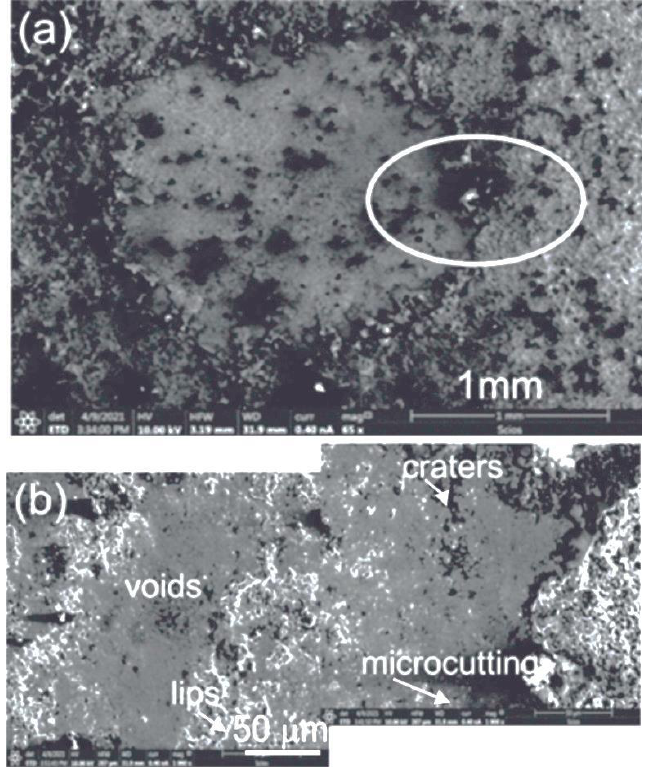
Figure 12. ( a ) SEM micrograph of the wear area after the erosion test of the composite coating (WC–Co + Cr); ( b ) magnified area selected in Figure 12a.